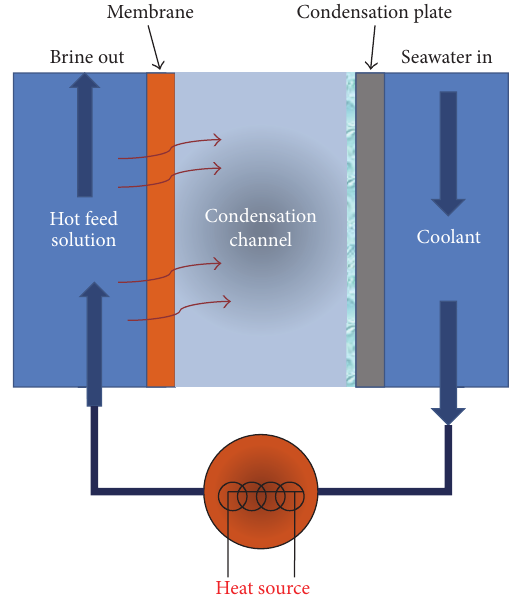
Figure 1: Principle of the membrane distillation (MD)